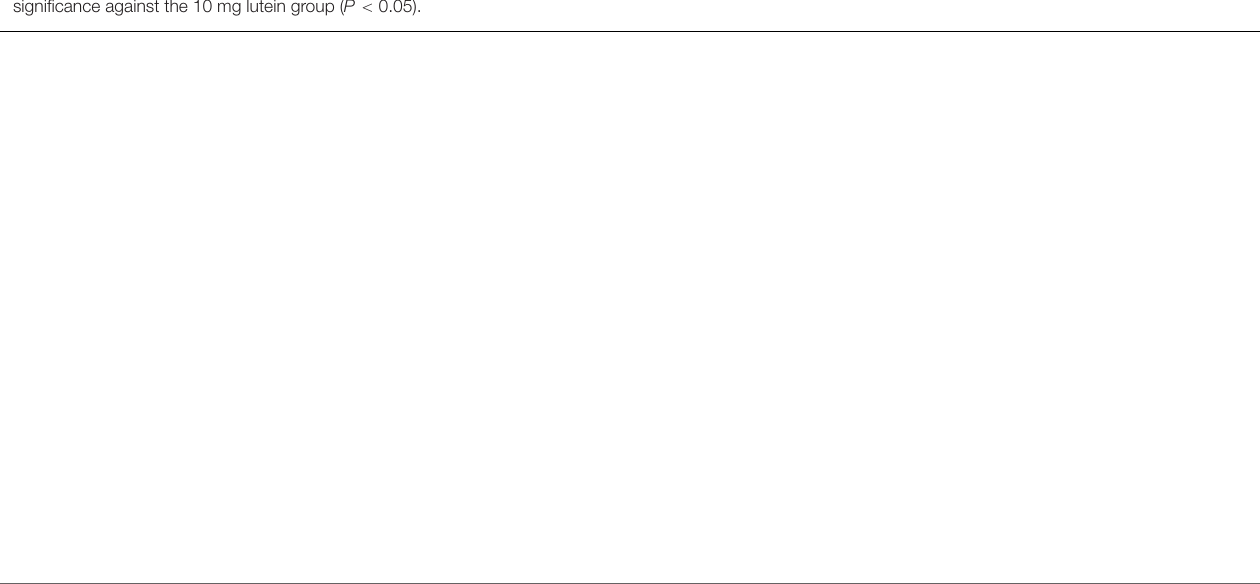
APPENDIX FIGURE 1 | The change of plasma lutein concentrations after lutein supplementations of different dosages among women (A) and men (C) . The change of plasma lutein concentrations after lutein supplementations with and without n-3 polyunsaturated fatty acids among women (B) and men (D) . ∗ indicates statistical significance against the 10 mg lutein group ( P <